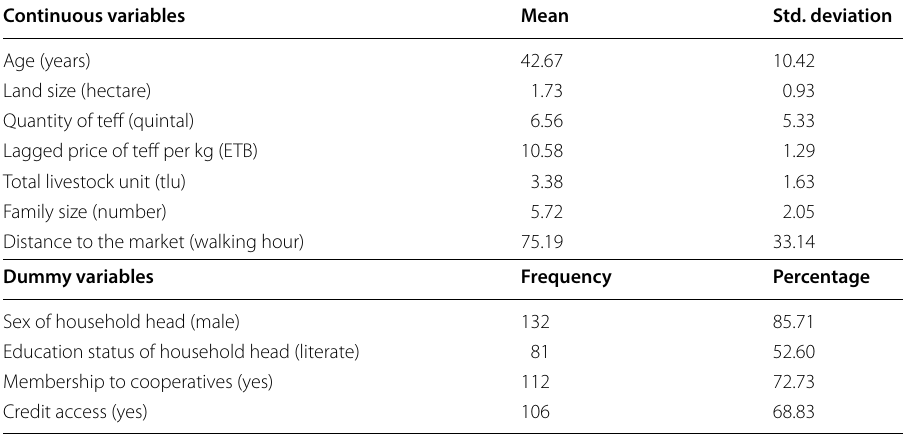
Table 1 Mean and proportion of sample households’ characteristics. Source: Survey data result,